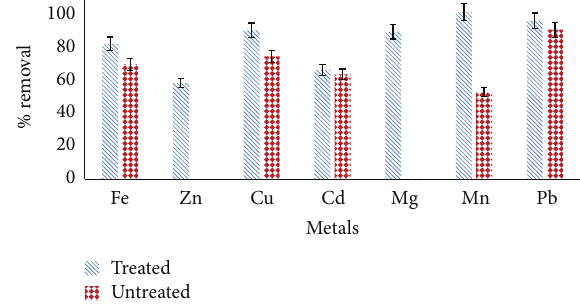
Figure 21: Comparison of treated and untreated MSP for removal of metal from wastewaters at final effluent point.